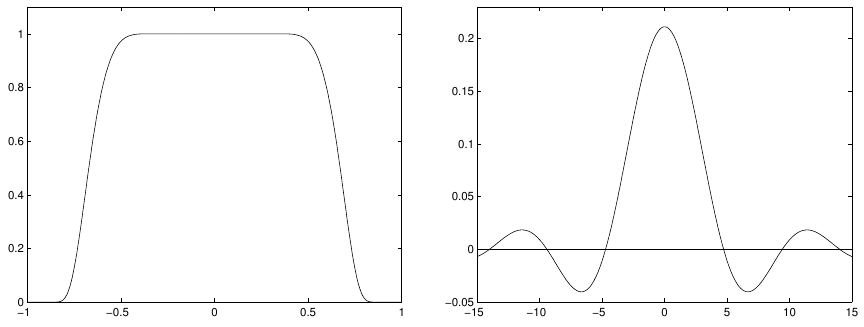
Figure 2. Infinitely differentiable flat-top characteristic function ( left ) and corresponding kernel ( right ), c = 0.05, b =